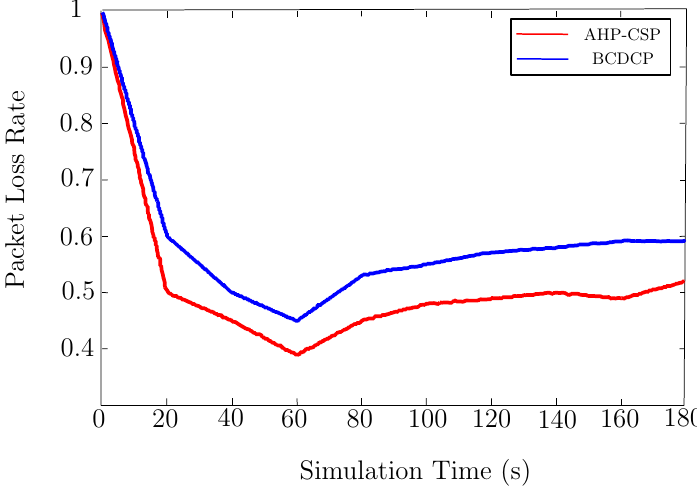
Figure 10. A comparison between AHP-CSP and BCDCP in terms of the packet loss